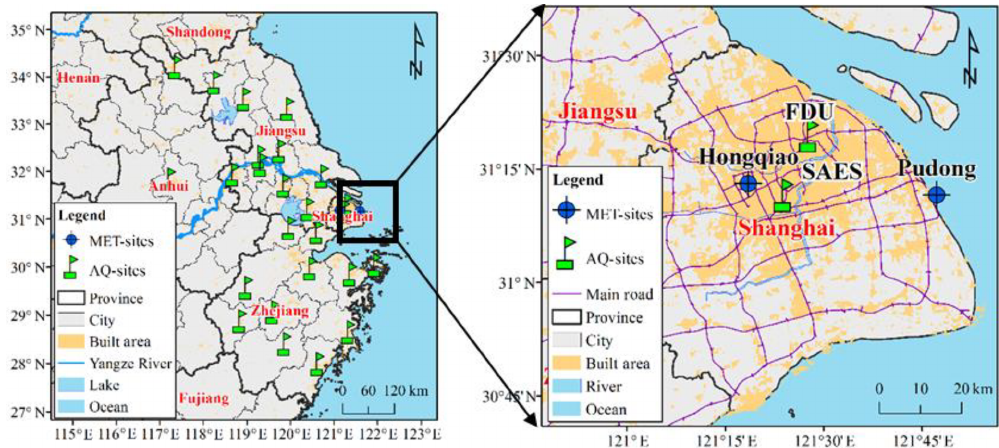
Figure 3. Locations of observation sites for WRF (two meteorology sites) and CAMx model performance evaluation (SAES site and Fudan University (FDU) site within Shanghai; another 23 air quality (AQ) sites distributed over Jiangsu, Zhejiang, and Anhui provinces with locations shown in Table